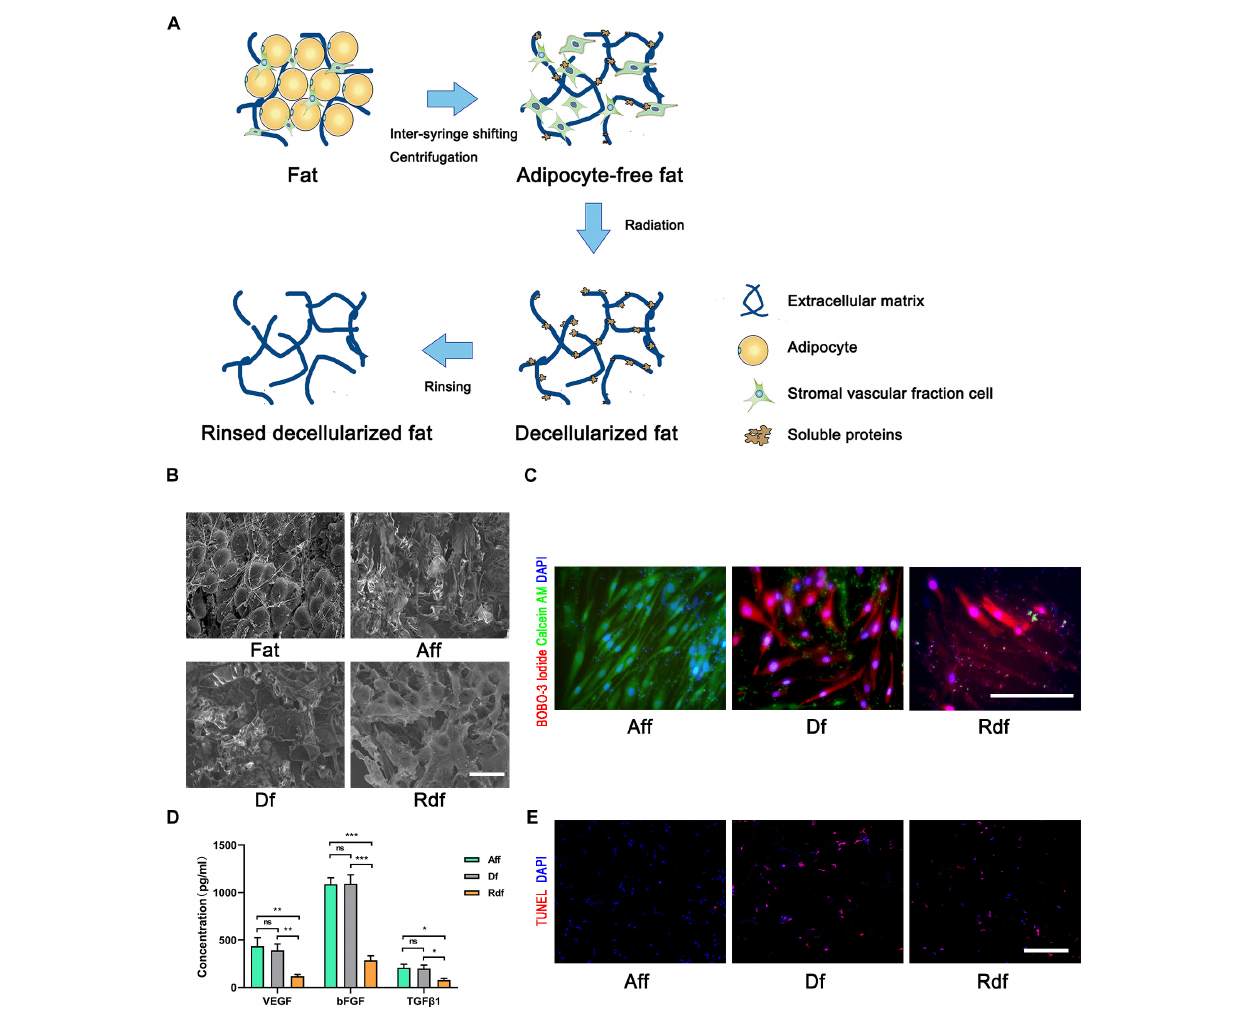
FIGURE 1 | Removal of adipose components in fat. (A) Illustration showing stepwise procedures eliminating adipose components in fat. (B) Scanning electron microscopy views of fat, Aff, Df, and Rdf. (C) Live/Dead assay staining measuring SVF cell death of Aff, Df, and Rdf after 72 h of culture. (D) ELISA analyses levels of VEGF, bFGF and TNF β 1 in Rdf compared with Aff and Df (* p < 0.05, ** p < 0.01, *** p < 0.001, ns = statistically non-significant). n = 3 independent experiments. (E) TUNEL staining to investigate cell apoptosis of Aff, Df, and Rdf on post-grafting day 1. Scale bar = 100 µ m.